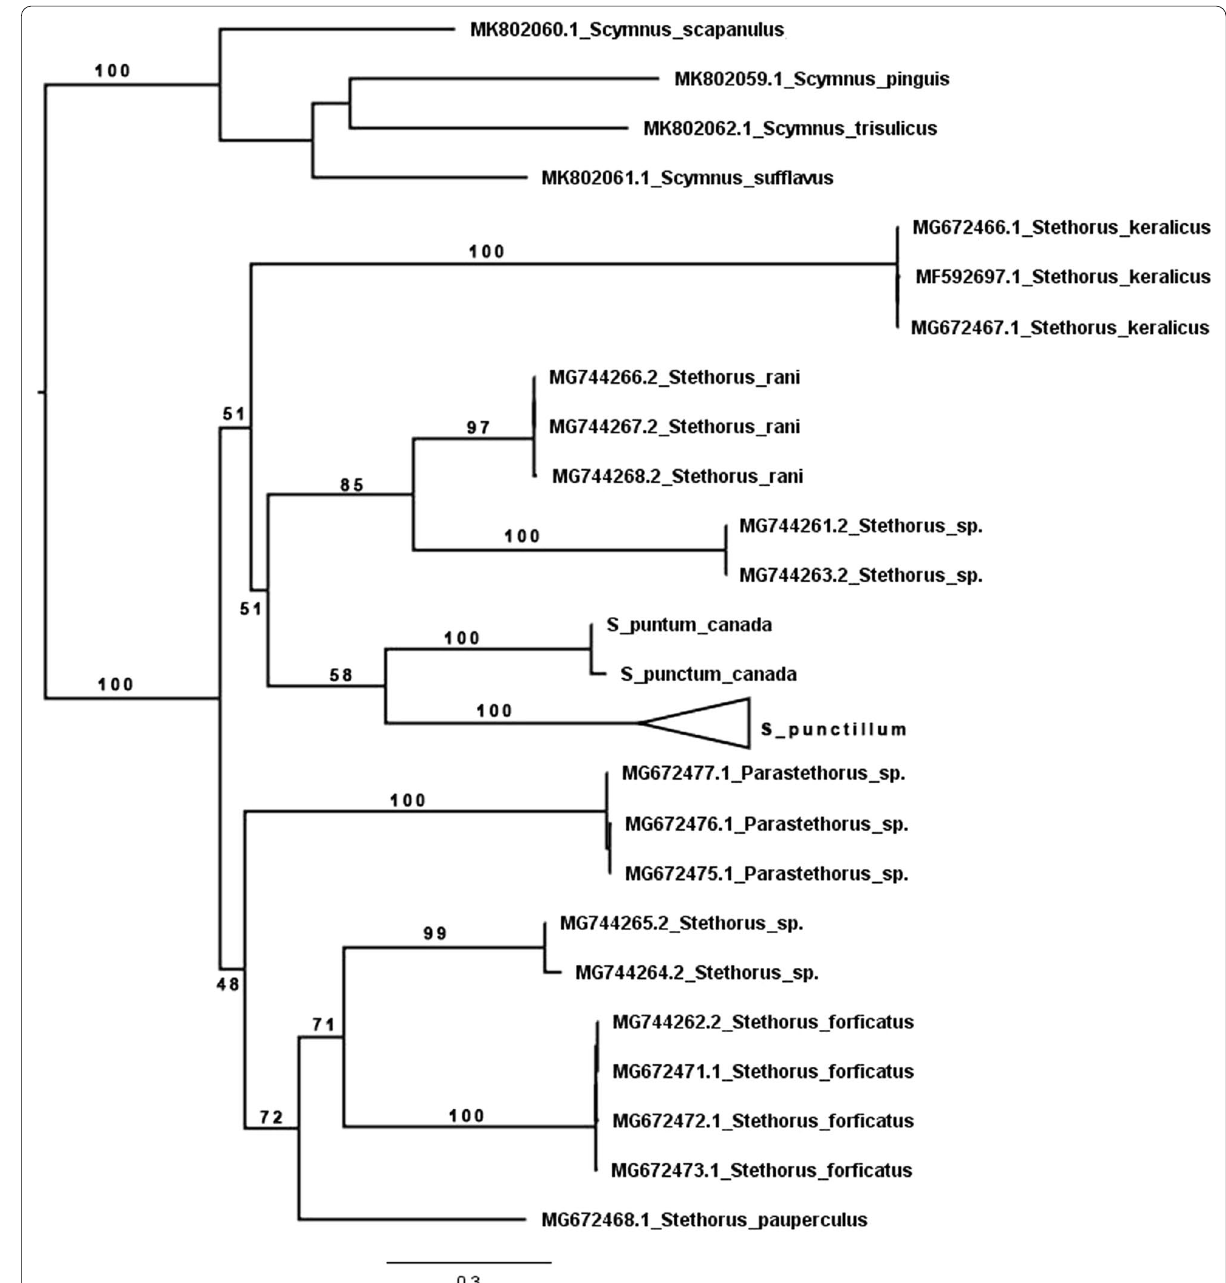
Fig. 1 A maximum-likelihood-based phylogenetic reconstruction of the Indian species of Stethorus and Parastethorus. The numbers represent bootstrap support for the respective branches as evaluated based on the online version of